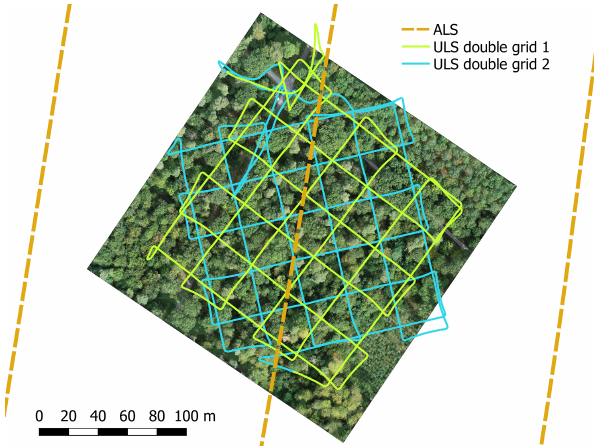
Figure 3. UAV-borne laser scanning (ULS) and airborne laser scanning (ALS) flight trajectories of plot KA10. Background: or- thophoto of the forest plot, acquired on 6 September 2019.